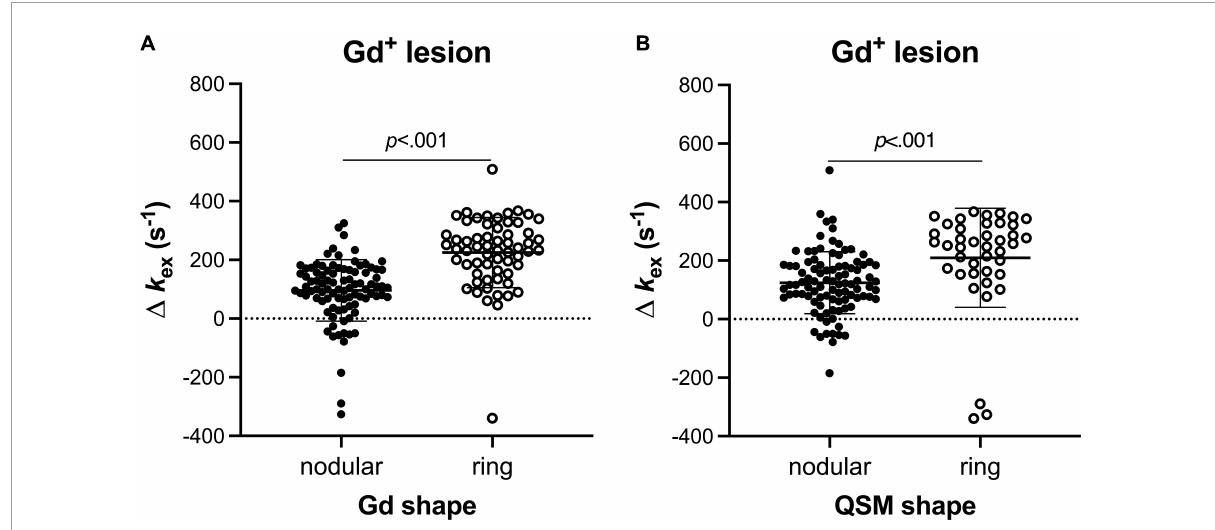
FIGURE2 Different Gd + MS lesions showed different levels of k ex values (Mann–Whitney U test). Lesions with ring Gd-enhancement presented higher k ex elevation than those with nodular Gd-enhancements (A) . For the lesions being both positive on post-contrast T1 imaging and QSM, the ones with ring QSM hyperintensity presented higher k ex elevation than those with nodular QSM hyperintensity (B)